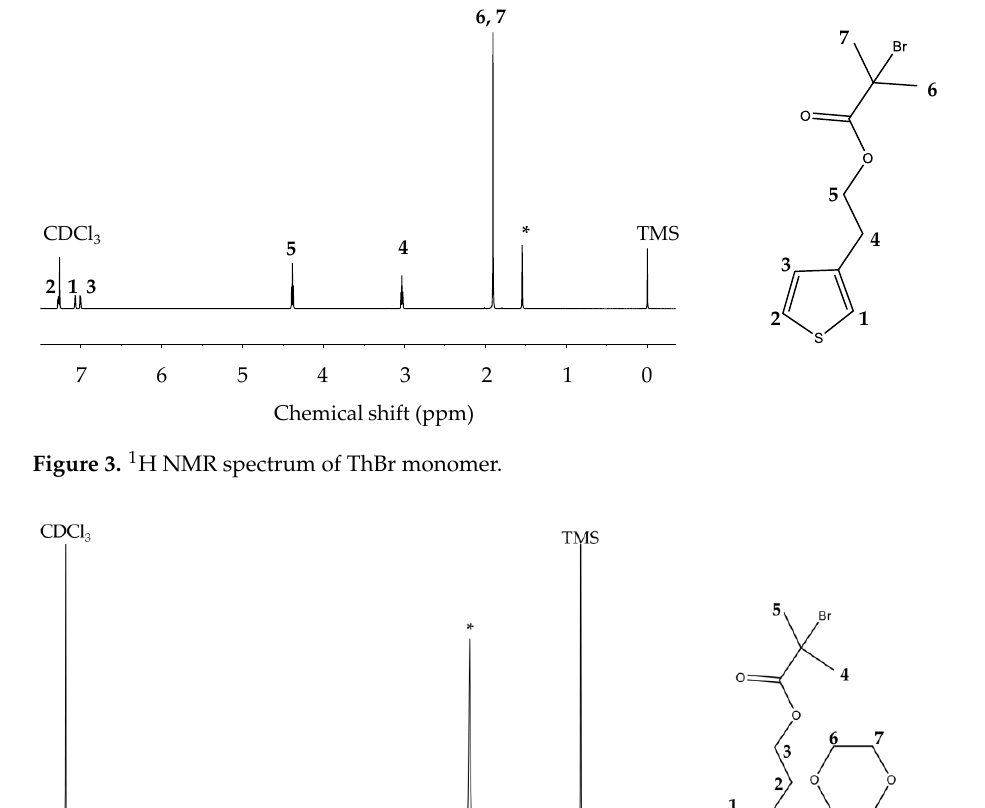
Figure 3. 1 H NMR spectrum of ThBr monomer.